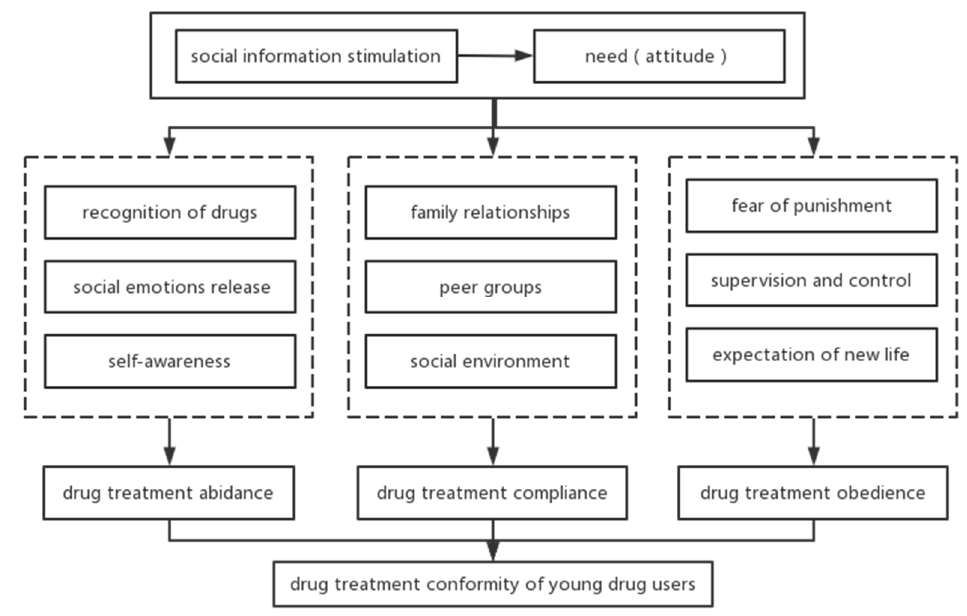
Figure 2. Factors influencing drug conformity behavior among young drug